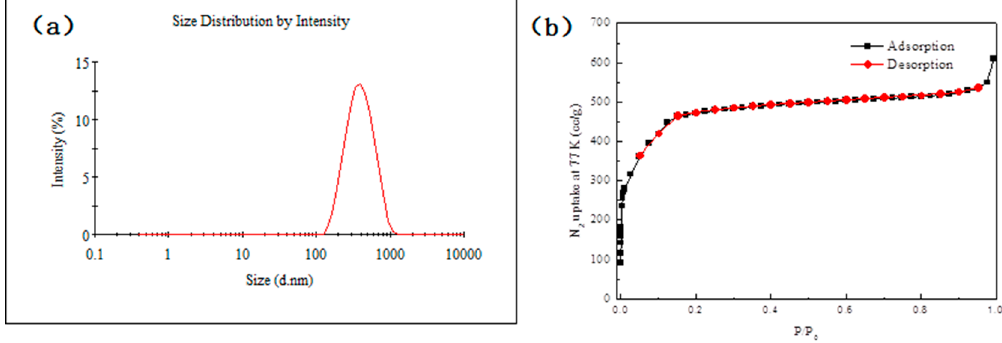
Figure 3. ( a ) Size distribution of MIL-100(Fe); ( b ) BET isotherm of MIL-100(Fe) at 77 K.